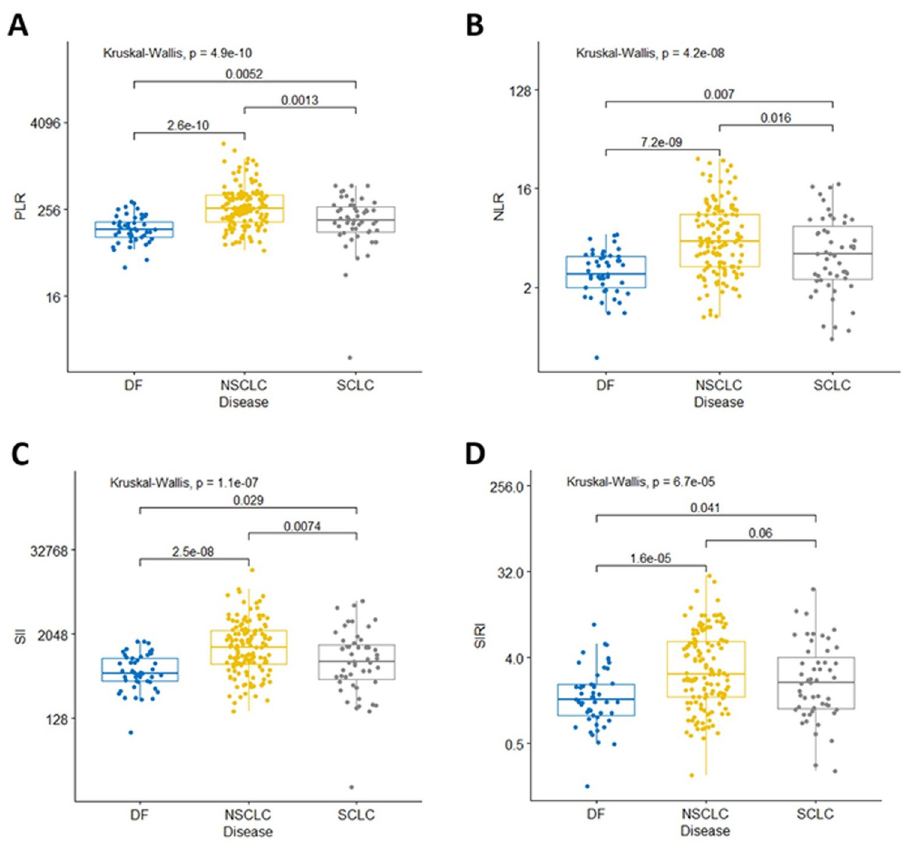
Fig 1. Systemic inflammation markers in our lung cancer cohort. Summary of NLR (A), PLR (B), SII (C) and SIRI (D) values for surgically resected patients with no evidence of disease (DF, n = 49), non-small cell lung cancer (NSCLC, n = 135), and small cell lung cancer (SCLC, n = 51) patients. Groups were compared with a Kruskal-Wallis test and pair-wise comparisons were done with a Dunn